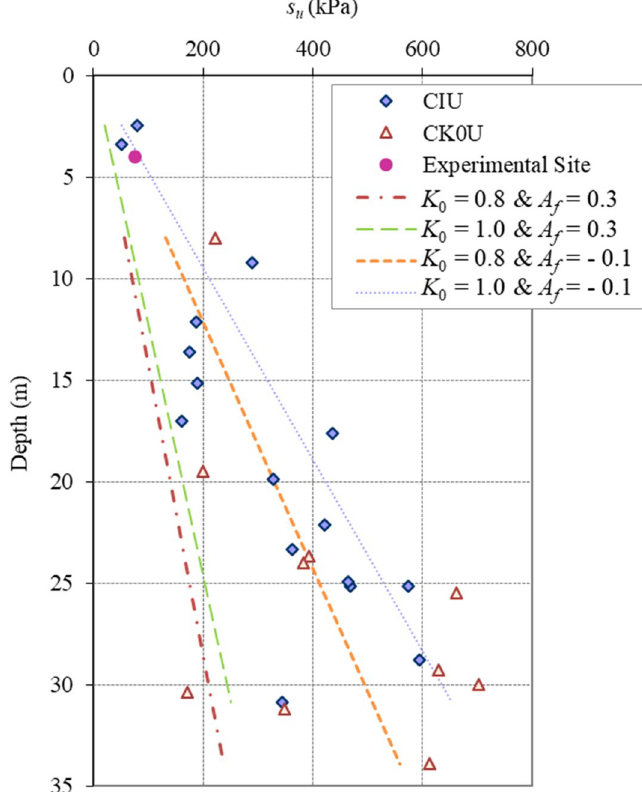
from triaxial u